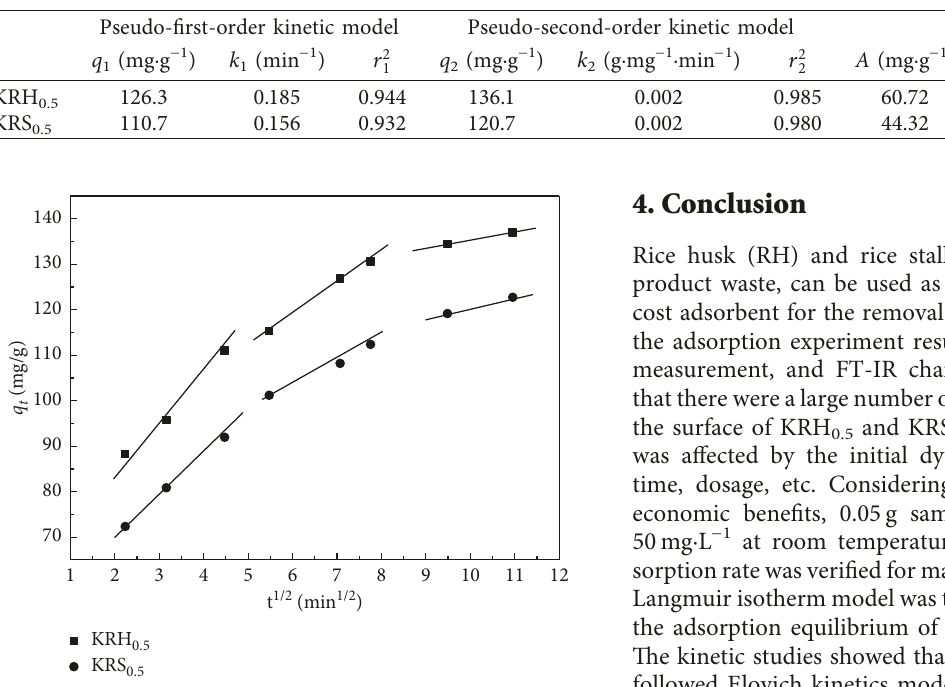
0.5 and KRS 0.5